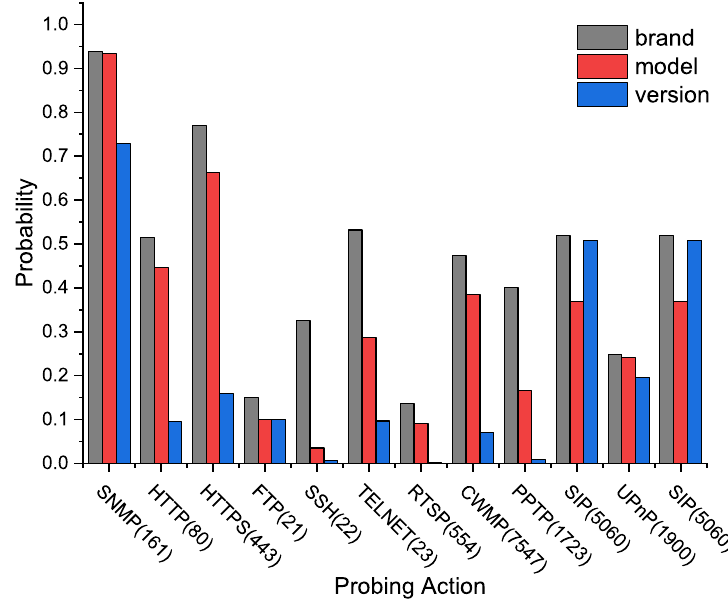
Figure 5. The probability of obtaining device fingerprints.